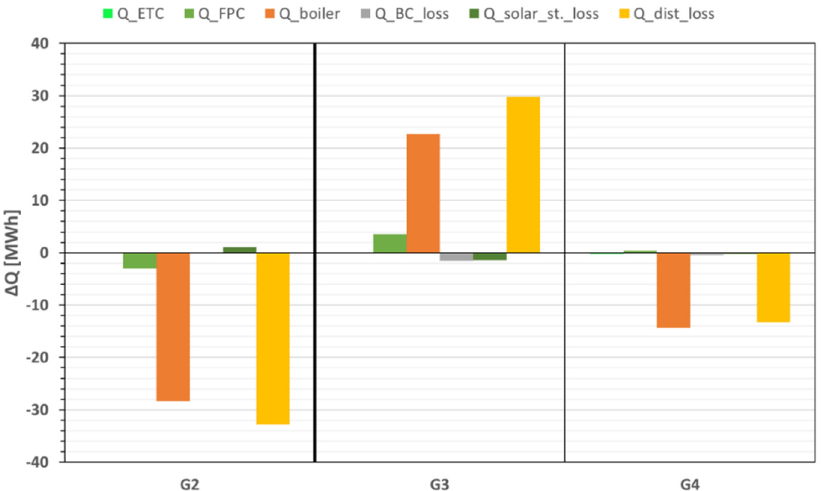
Figure 9. Energy balance difference—Relative changes in lost and supplied energy compared to the reference variant (G1) for the variants of the GRUDIS concept. The bold line indicates a change in pipe manufacturer; G1 and G2 employ M2, while G3 and G4 employ M1 and M3, respectively—see Table 7 for overview.